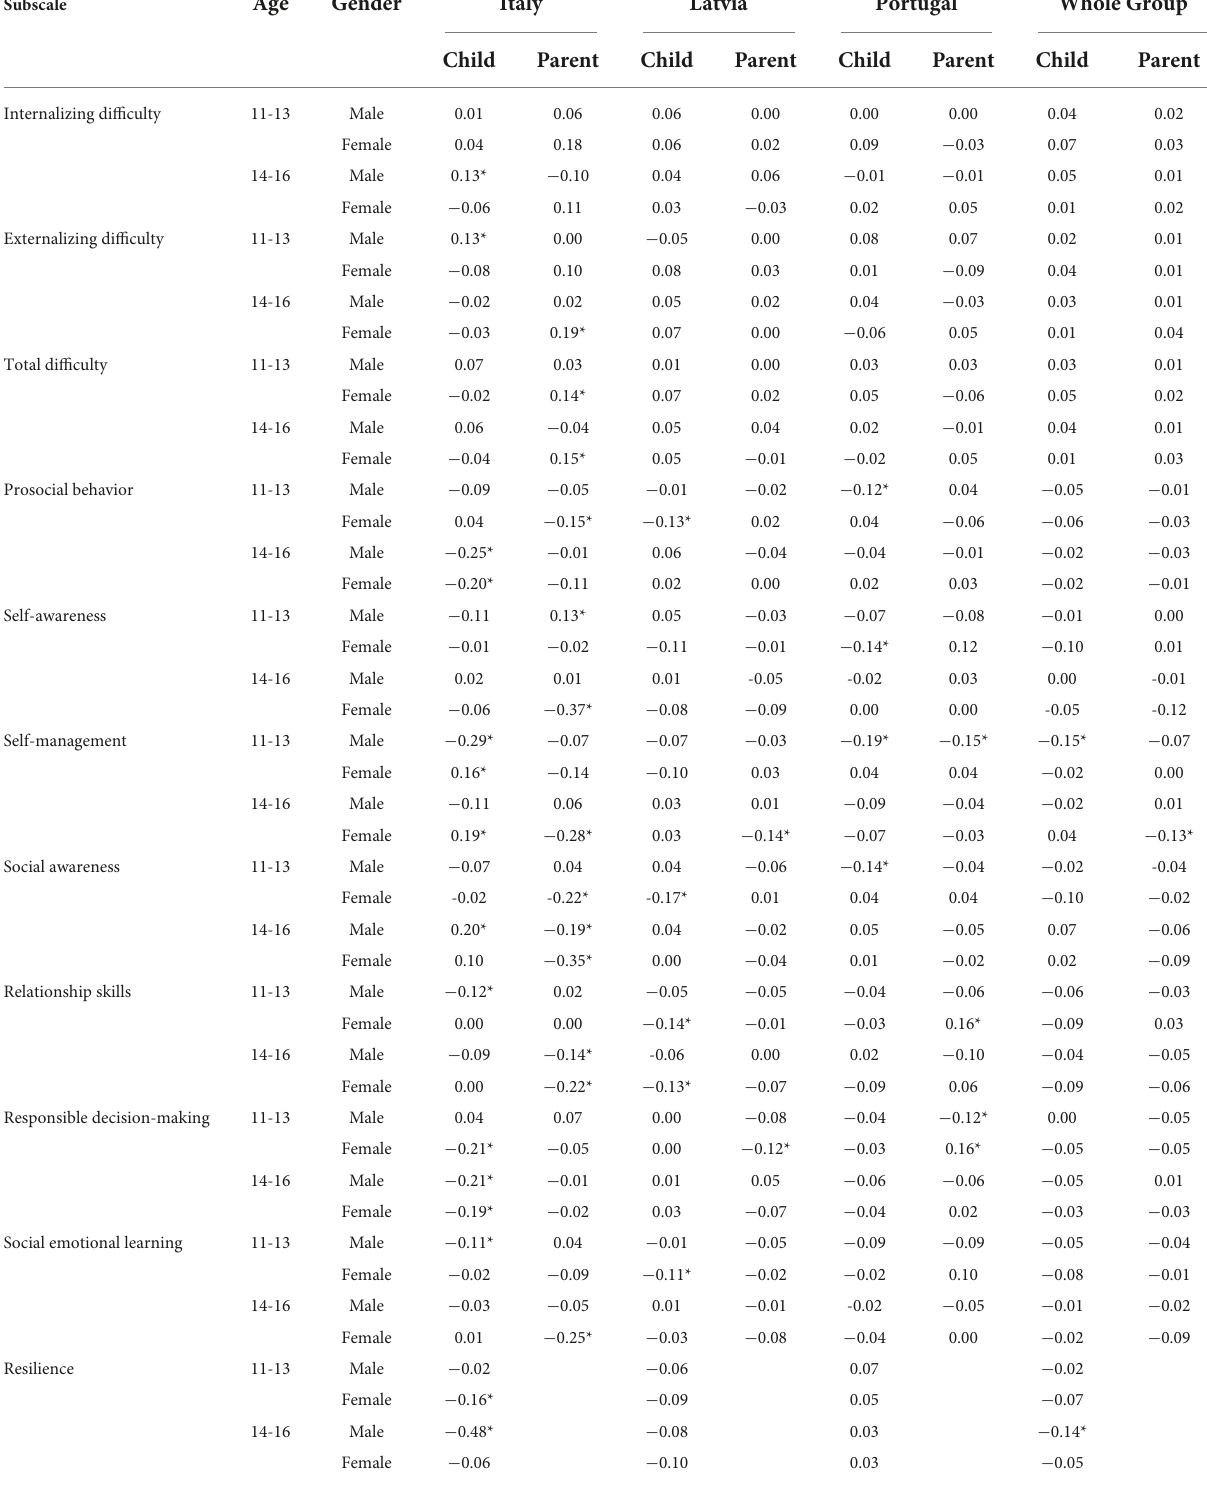
TABLE 7 Adolescent and parent-reported changes in mean SDQ and SSIS-SEL scores and adolescent self-reported CD-RISC-10 scores (n = 512), October 2020 (T1) – May 2021 (T2).